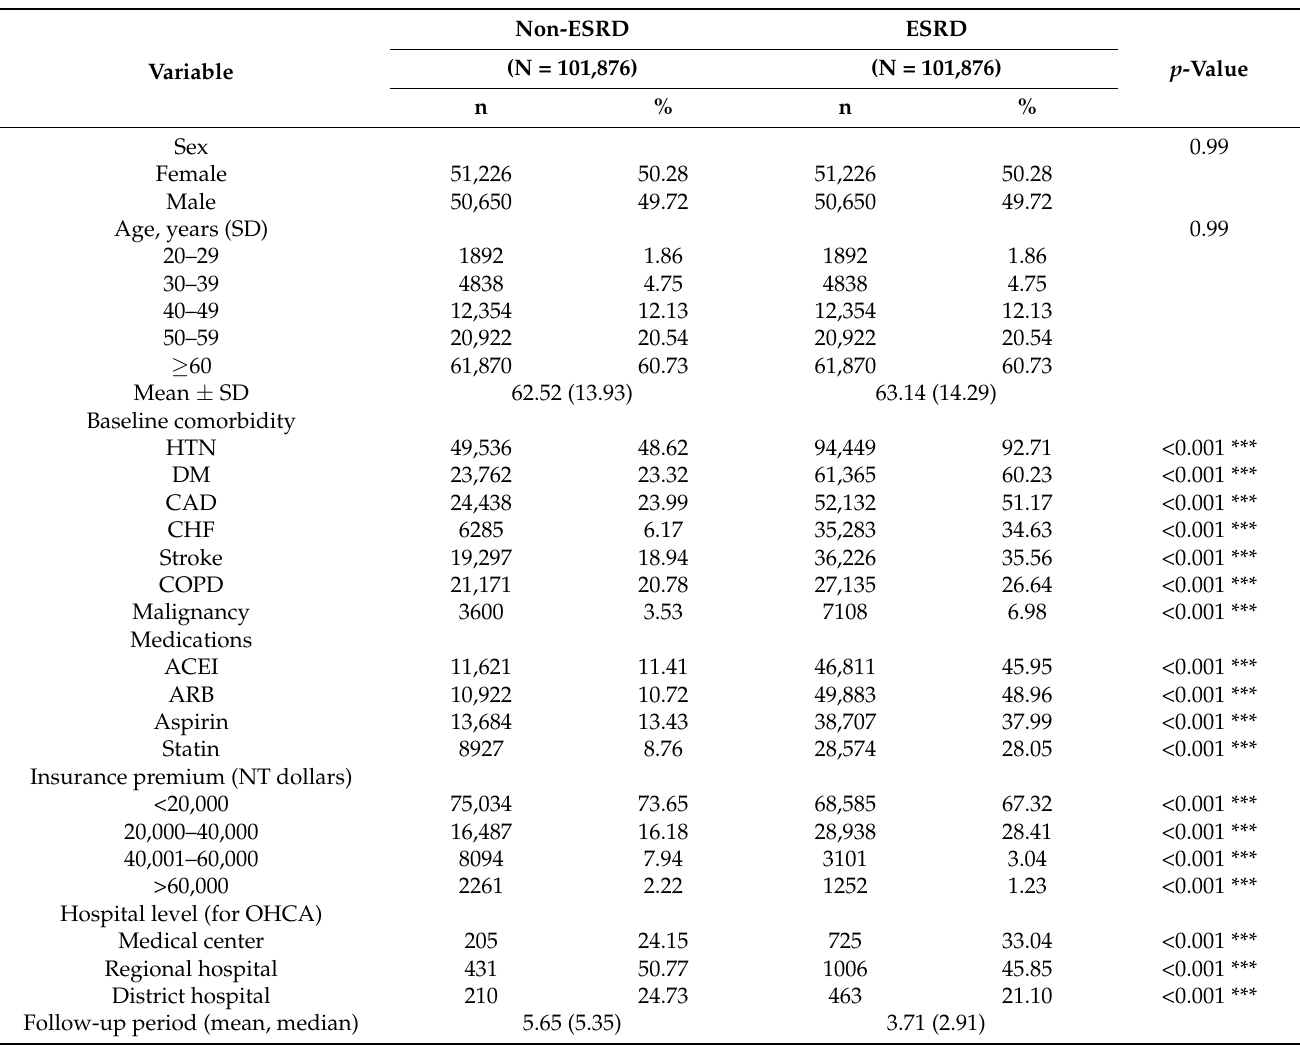
Table 1. Demographic characteristics, baseline comorbidities, medications, household income, and treating hospital levels for OHCA between the frequencies matched ESRD and non-ESRD